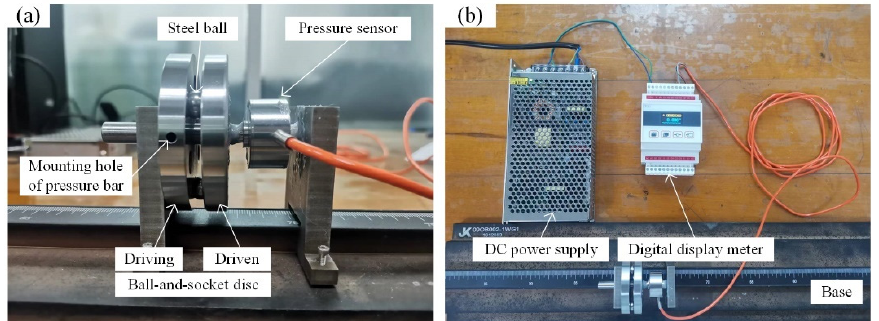
Figure 20. Experimental set up. (a) The ball ‐ and ‐ socket contact pair. (b) Force acquisition device.